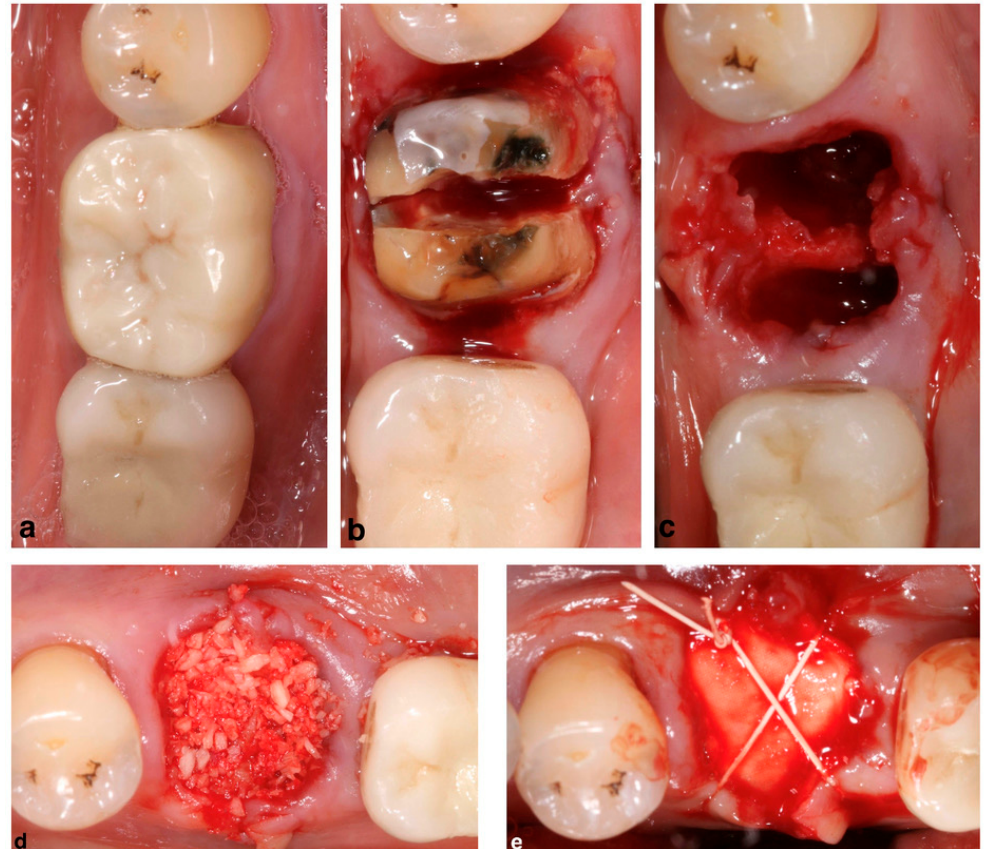
Figure 3. Alveolar ridge preservation with allogenic bone graft and collagen membrane: ( a ) mandibular molar to be extracted; ( b ) mandibular molar sectioned to allow an atraumatic extraction, preserving the alveolar bone, especially on the buccal and lingual aspect; ( c ) molar successfully extracted, preserving the buccal and lingual bone, as well as the septum between the roots; ( d ) freeze-dried bone allograft placed in the socket; and ( e ) collagen resorbable membrane placed over the bone graft and sutured to secure the placement of the membrane and approximate the buccal and lingual soft tissue.